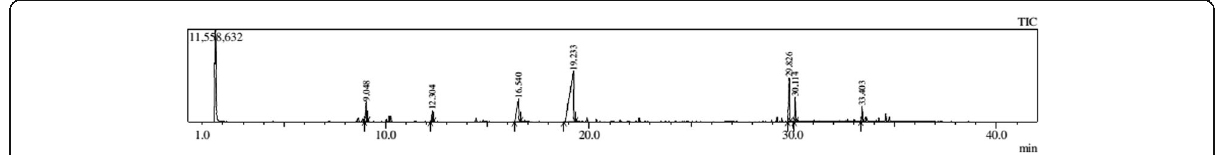
Fig. 4 Chromatogram obtained from GC-MS/MS analysis shows the chemical composition and abundance of some compounds of the bay